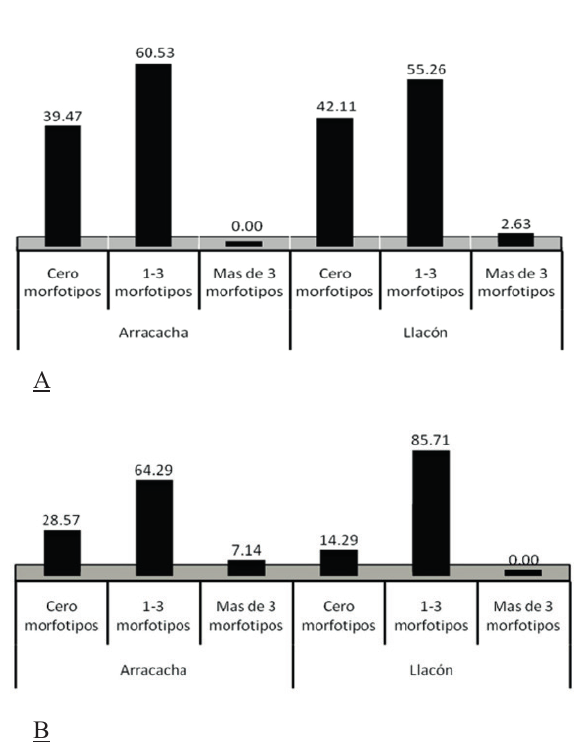
Figure 2. Percentage of farmers surveyed in the districts of Huacrachuco (A) and San Pedro de Cholón (B) according to the number of arracacha ( A. xanthorrhiza) and yacón ( S. sonchifolius ) morphotypes conserved in